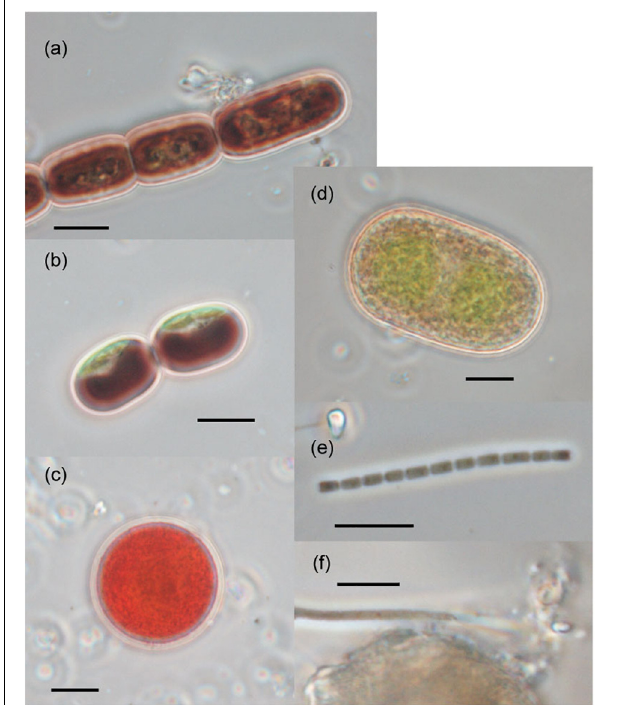
FIGURE 4 | Photographs of the phototrophs observed on the ablation ice surface on glaciers in Svalbard. (a) Ancylonema nordenskiöldii ; (b) Mesotaenium bregrenii , (c) Chlamydomonas nivalis , (d) Cylindrocystis brébissonii ; (e) Oscillatoriaceae cyanobacterium (f) Phormidesmis priestleyi . Scale bars are all 10 µ m. All photographs were taken with a phase contrast microscope.